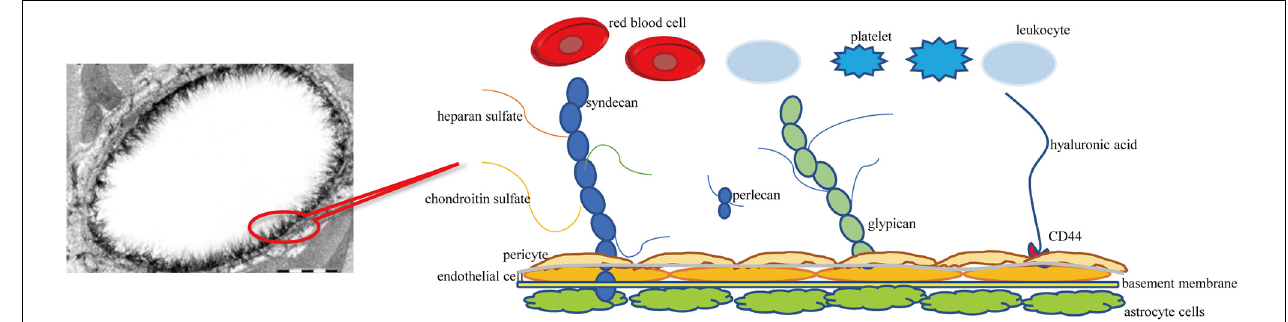
FIGURE 1 | Schematic diagram of cerebral vascular endothelial glycocalyx. Syndecan and glypican are membrane-bound proteoglycans-core skeletons, to which chondroitin sulfate and heparan sulfate are connected. Syndecans are transmembrane proteoglycans. Glypicans attach to the cell surface through glycosylphosphatidylinositol anchors. Hyaluronic acid is connected to the endothelial cell membrane through the CD44